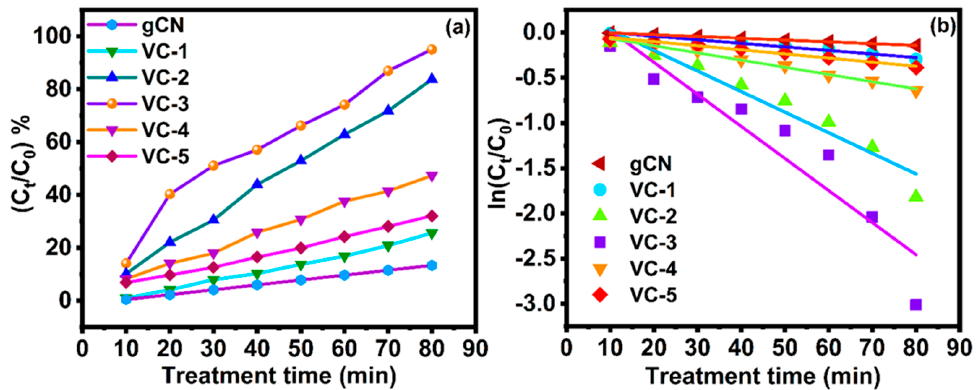
Figure 8. MCP degradation efficiency: ( a ) photocatalytic ability of gCN and V/Cu/gCN (VC-1 to VC- 5) nanosheets and ( b ) N1s spectra of gCN and V/Cu/gCN nanosheets